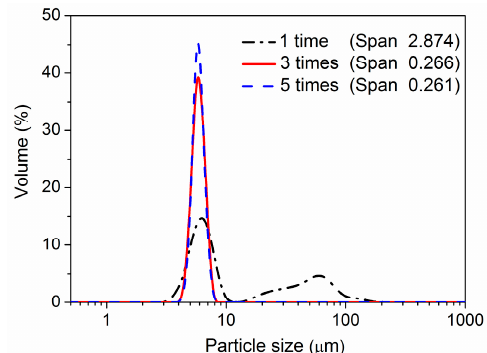
Figure 3. Size distributions of the semi-IPN3 microspheres prepared under different number of trans-membrane passes.